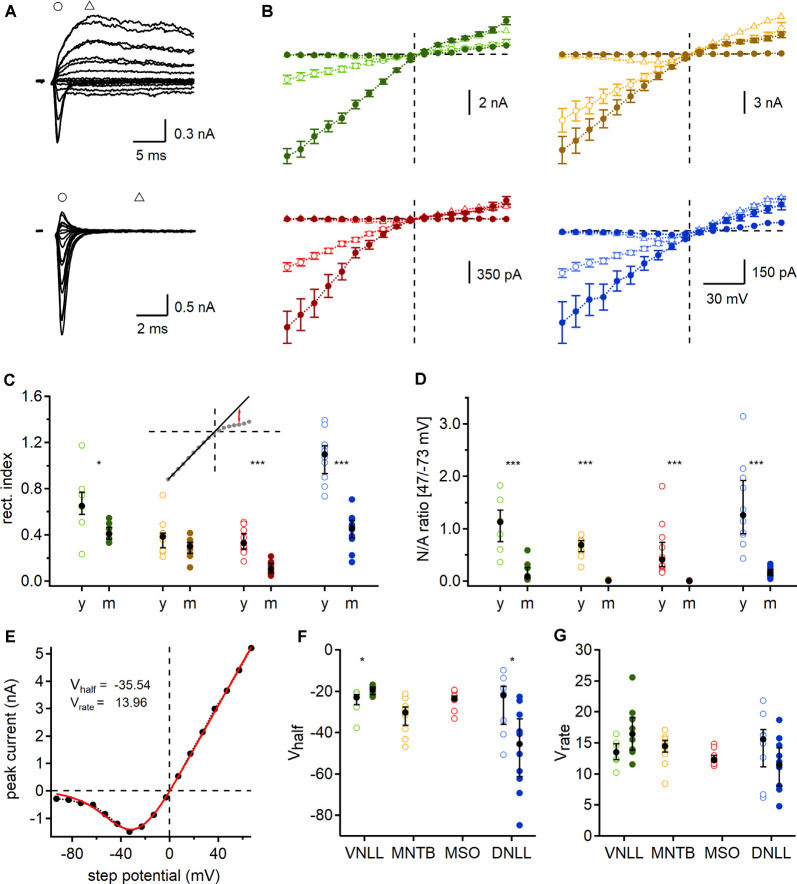
Developmental regulation of AMPAR and N-methyl-D-aspartic acid receptor (NMDAR) mediated currents. (A) Exemplary currents of a single fiber stimulated P9 (top) and P84 (bottom) MSO neuron at different step potentials. Early, rapid deflection (circles) was considered as a peak of AMPAR mediated EPSC and current 5 ms afterward (triangles) as NMDAR peak. (B) AMPAR (circles) and NMDAR (triangles) peak currents of P9/10 (open symbols) and mature (filled symbols) neurons. Data points as mean ± SEM. (C) Rectification index (RI) of AMPAR mediated IV-curves. Inset: regression line (black line), fitted at the first eight negative potential values, used to estimate the RI at 47 mV (red arrows). (D) Ratio of NMDAR (at 47 mV) to AMPAR (at −73 mV) peak currents (N/A). (E) Mean NMDAR IV relationship of P9/10 MNTB neurons fitted with Boltzmann function (red line). Vhalf and Vrate describe the non-linear NMDAR kinetics. (F,G) NMDAR voltage-dependent activation in each nucleus and age group given by Vhalf (left) and Vrate (right). Cell numbers per nucleus and age group as in Figure 4. Markers and color-coding as in Figure 2. Black symbols of C,D,F, and G show median with first and third quartiles. *p < 0.05, ***p < 0.001.